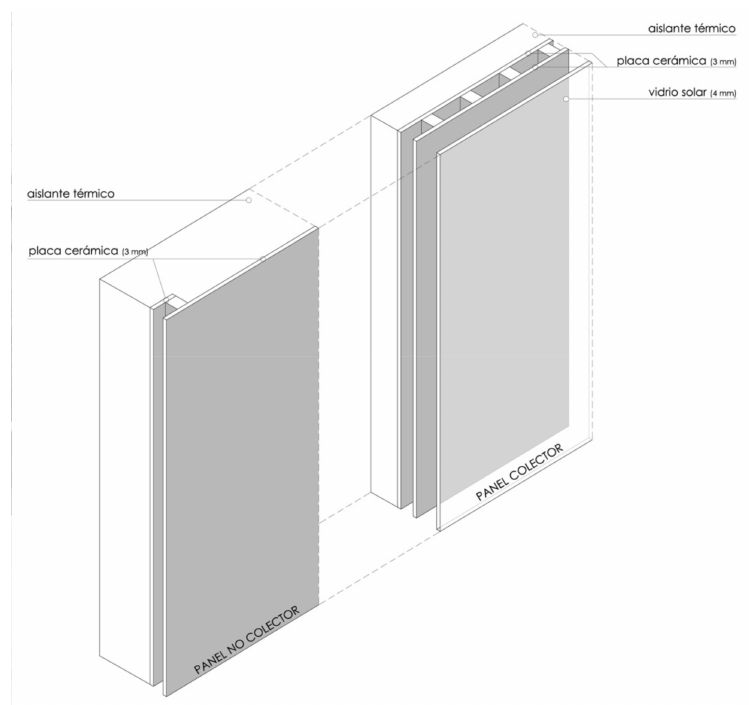
Figure 1. Configuration of new ceramic collector panel with a glass cover and a non-collecting ceramic panel without glass. Reproduced with permission from reference